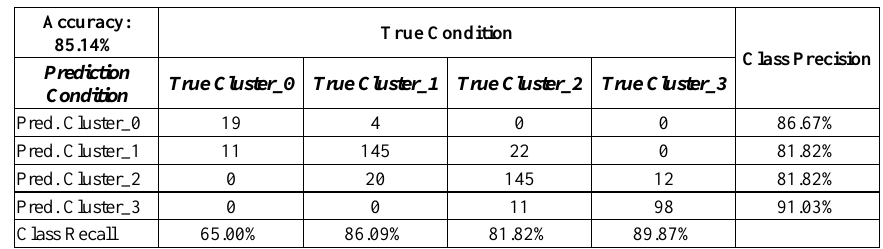
Model Performance with the Forward Selection